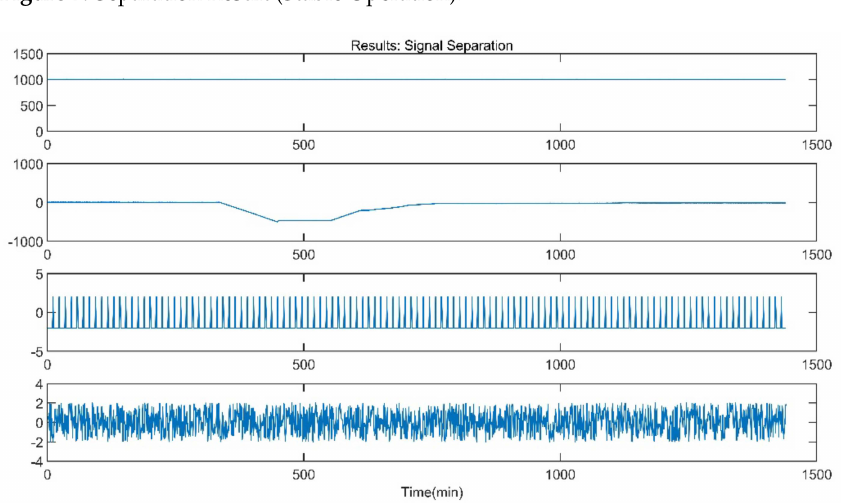
Figure 8. Separation Result (Peak Load